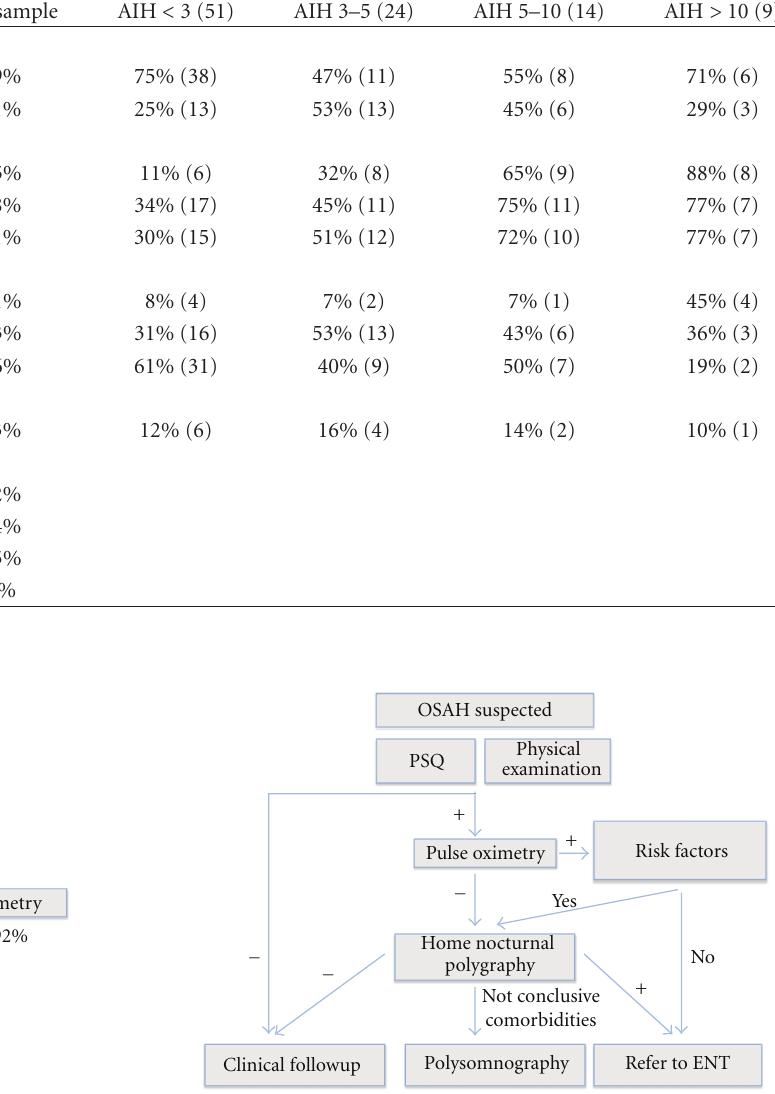
Figure 1: Assessment of screening tools related with home noctur- nal polygraphy. S: sensitivity E: specificity PPV: positive predictive value NPV: negative predictive value.